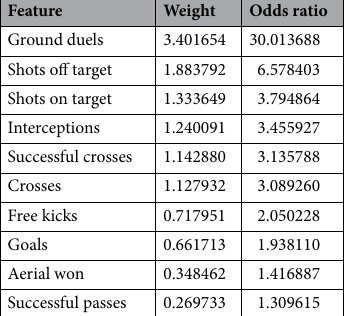
Table 3. Logistic regression model top 10 features estimated weights and odds ratio ordered by odds ratio value. A single change in a feature by one unit increases the estimated odds (probability of predicting class male over the probability of predicting class 0) by a factor of its corresponding odds ratio.